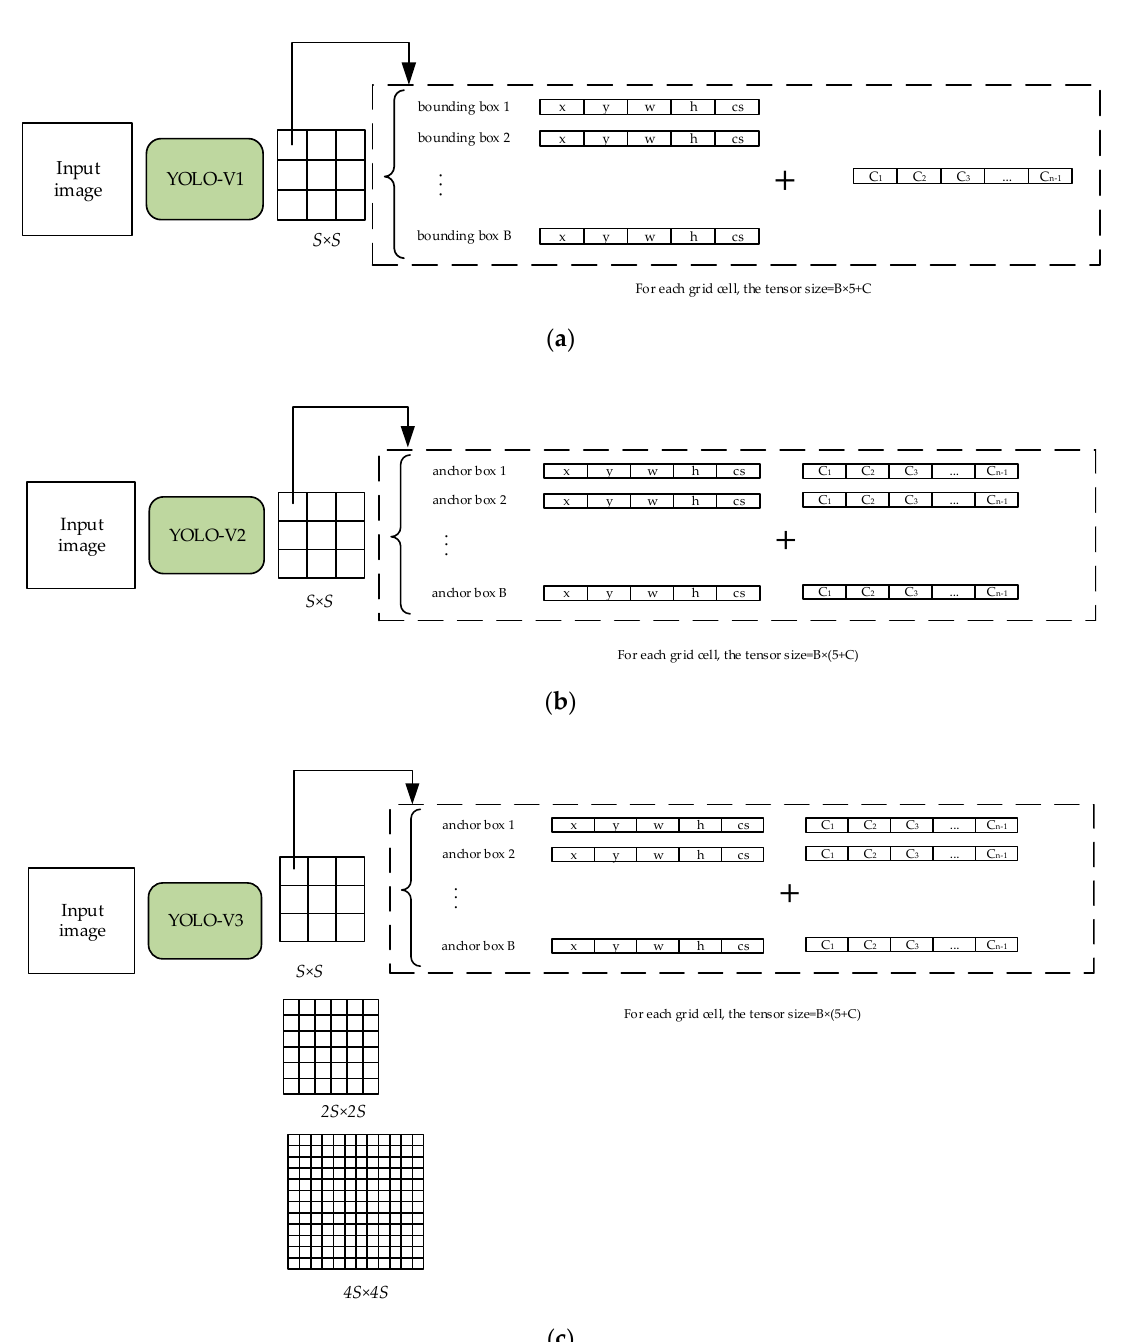
Figure 1. The comparison of YOLO-V1 (you-only-look-once V1) to YOLO-V3. YOLO-V1 has stunning detecting speed compared to Faster R-CNN. However, its accuracy is lower than other one-stage detectors such as SSD. In addition, for each grid cell, only one target can be detected. To improve the deficiencies of YOLO-V1, in 2017 the advanced version of YOLO (i.e., YOLO-V2) was proposed. YOLO-V2 (in Figure 1b) offered several improvements over the first version. Firstly, instead of FC (Full Connected Layer), YOLO-V2 adopted FCN (Full Convolutional Layers). The feature extraction network was updated to Darknet19. Secondly, utilizing the ideal of Faster R-CNN, YOLO-V2 introduced the concept of anchor box to match the targets of different shapes and sizes. Moreover, Batch Normalization was also adopted. The accuracy of YOLO-V2 was drastically improved compared to